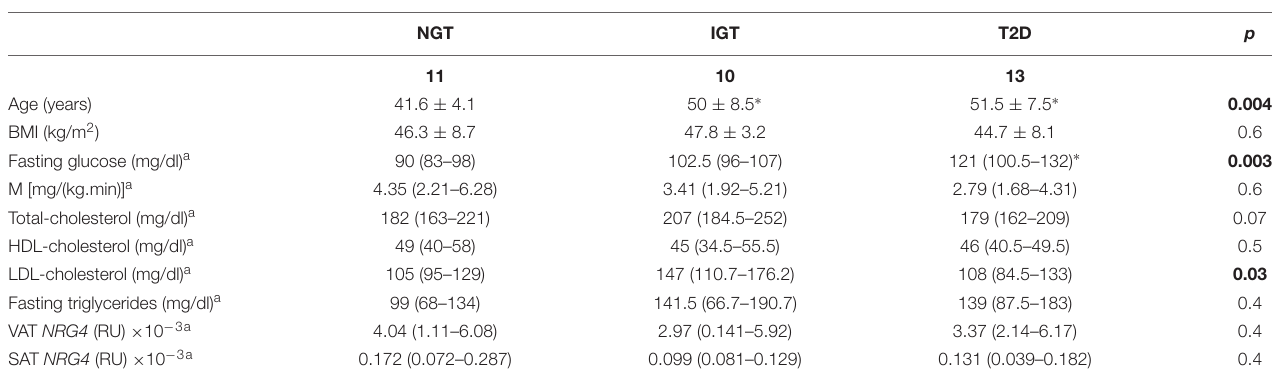
FIGURE 2 | (A,B) Bivariate correlation between NRG4 and TMEM26 gene expression in VAT (A) and SAT (B) . (C) NRG4, TMEM26, and UCP1 gene expression in adipose tissue fractions (SVF and adipocytes) in both SAT ( n = 17) and VAT ( n = 20). ∗∗ p < 0.01 and ∗∗∗ p < 0.001 compared to gene expression in VAT SVF cells. TABLE 4 | Anthropometric and clinical characteristics according to glucose tolerance in cohort